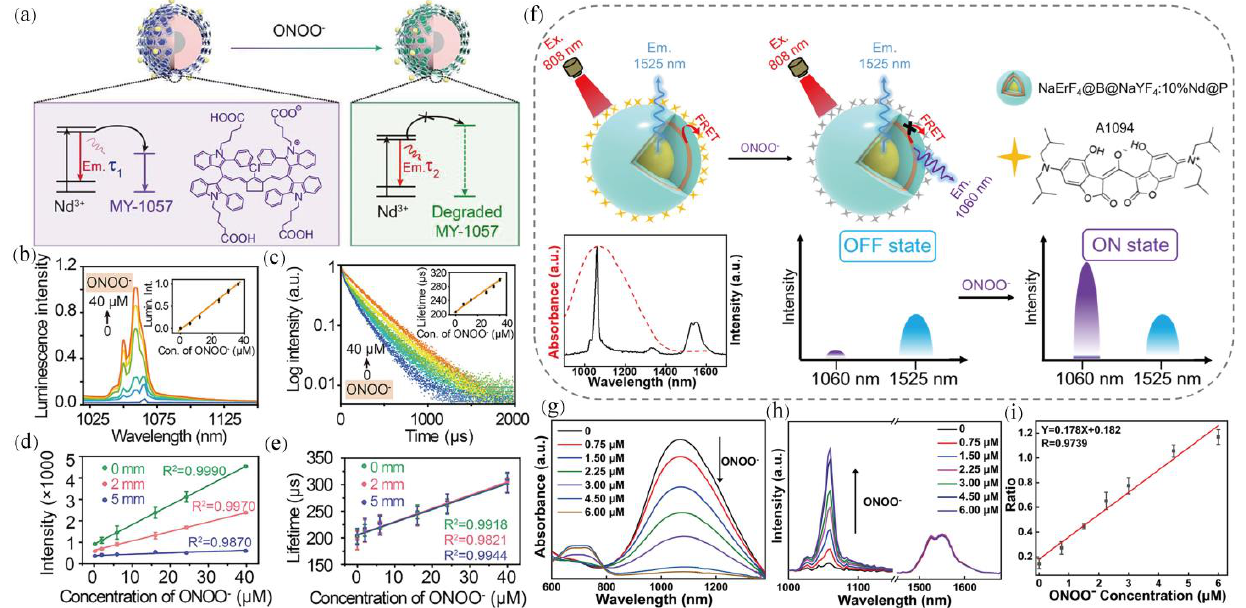
Figure 9. ( a ) Schematic design of the LnNCs@MY − 1057 for ONOO − detection. ( b ) Luminescence emission intensity of LnNCs@MY − 1057. ( c ) Lifetime response of LnNCs@MY-1057. ( d ) Plot of intensity changes under different penetration depths. ( e ) Plot of lifetime changes under different penetration depths. Adapted, with permission, from Ref. [98]. Copyright 2020, Wiley − VCH. ( f ) Schematic design of the LnNCs@A1094 for ONOO − detection. ( g ) Absorption spectra and ( h ) NIR − II spectra of LnNCs@A1094 upon gradual addition of ONOO − . ( i ) Plot of fluorescence ratio (I 1060 /I 1525 ) changes as a function of ONOO − concentration. Adapted, with permission, from Ref. [51]. Copyright